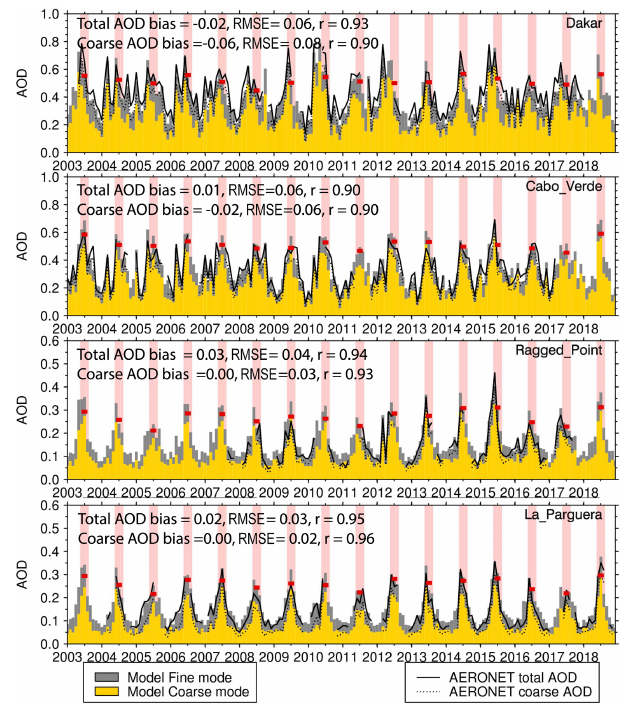
Figure 3. Monthly mean version 3 L2 AERONET and MRC 550nm modal AODs at four African dust-impacted sites: Dakar, Cabo Verde, Ragged Point, and La Parguera from east to west. JJA are highlighted with pink shading, and JJA seasonal average total AODs from MRC are shown with red bars. Annotations for each time se- ries show bias, RMSE, and correlation ( r ) of monthly averages cal- culated from the